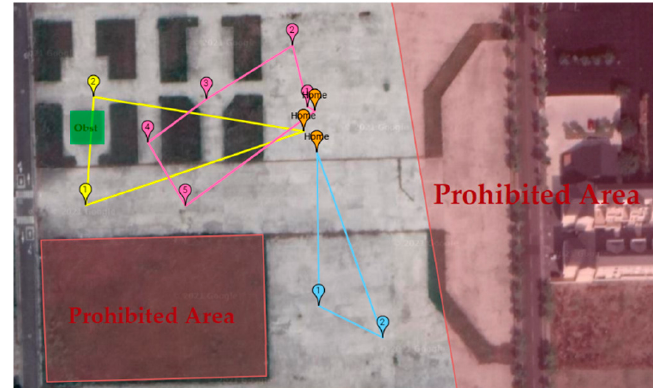
Figure 23. Route planning results of the first experiment.